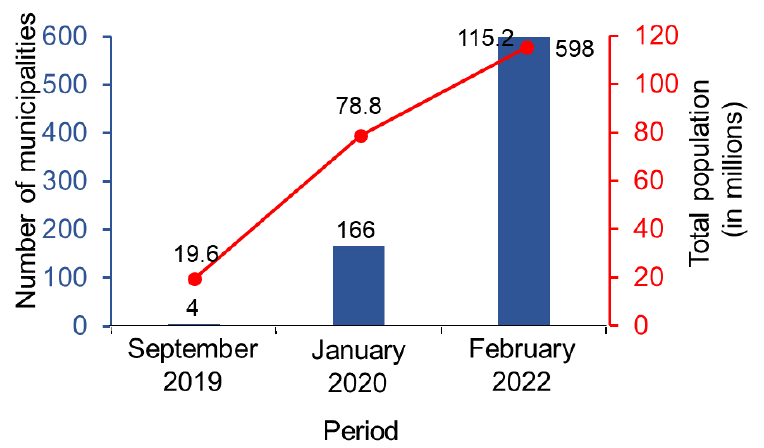
Figure 5. Number of municipalities and population (in millions) with a strong social demand and motivation to increase global warming countermeasures [31].